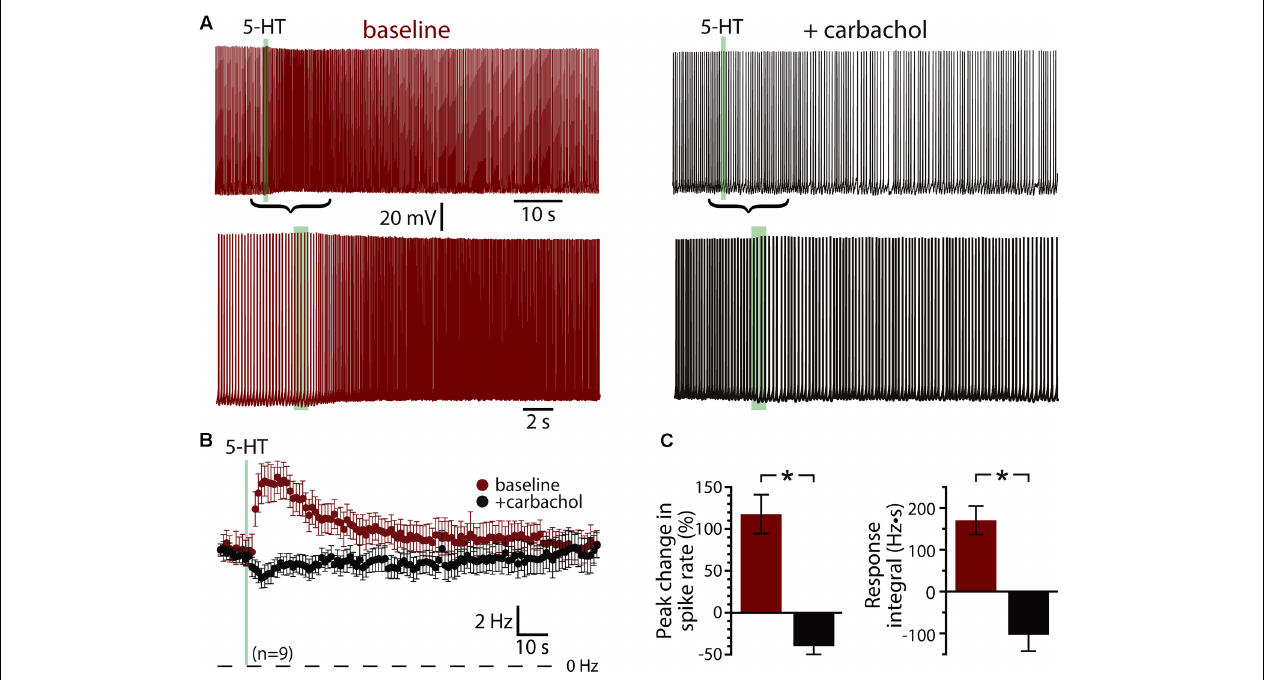
FIGURE 2 | Serotonergic and cholinergic excitation share signaling mechanisms. (A) Voltage traces showing responses to focal application of 5-HT (100 µ M, 1 s, ∼ 15 psi; green bar) during periods of action potential generation in control conditions (left; +66 pA DC current injection) and after bath-application of the cholinergic agonist carbachol (right; no current injection in 50 µ M carbachol). Lower traces show 5-HT responses in the two conditions at a faster timescale. (B) Plots of mean ( ± SEM) instantaneous spike frequencies in baseline conditions (red) and in the presence of 50–100 µ M carbachol (black) for 9 neurons. (C) Comparisons of the percent change in firing (left) and response integrals (right) for serotonergic responses in control and carbachol conditions.